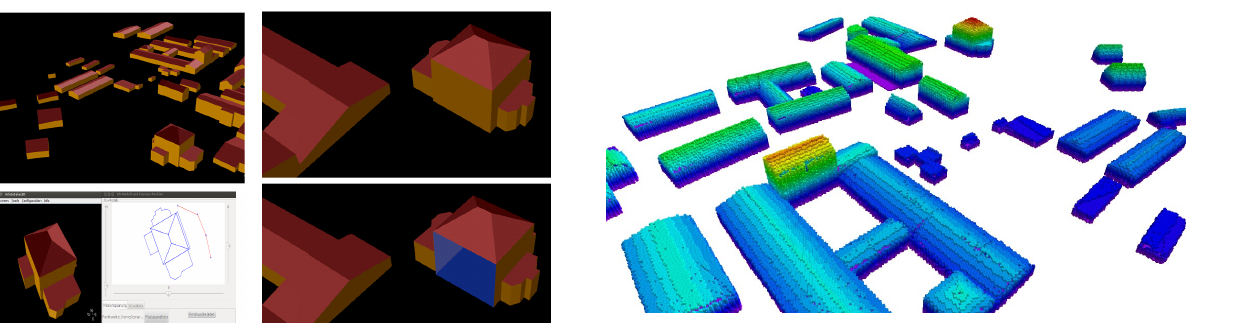
Figure 2: Overview on the front-end of the mission planing sys- tem. Semantic building models of an area of interest (top, left). Focus on specific building (top, right). Facade surface selection (bottom, right). Path specification (bottom, left).